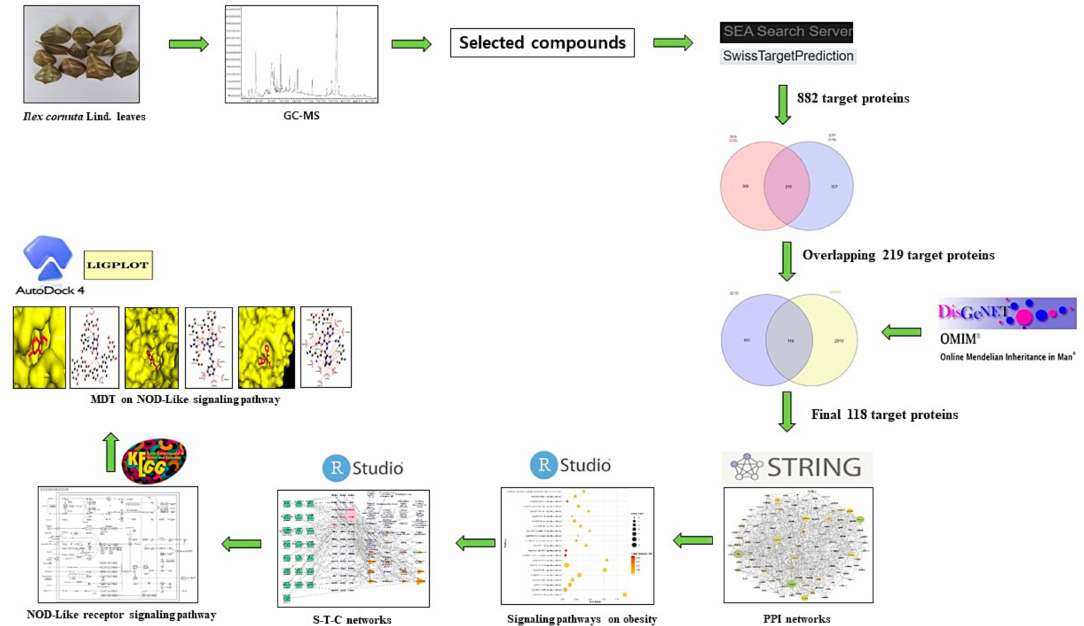
Figure 1. Workflow diagram of network pharmacology analysis of ICLs against